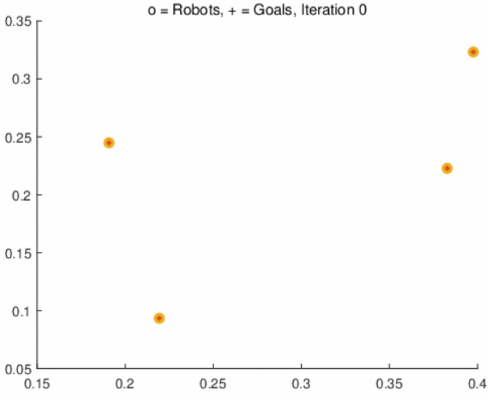
Figure 4. Initial positions of